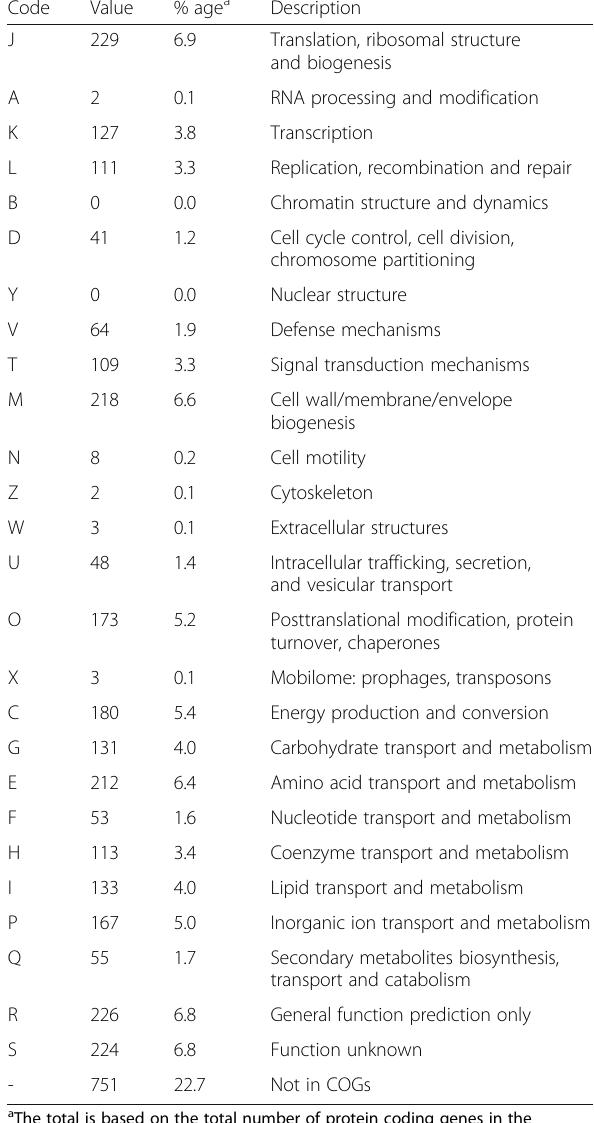
Table 4 Number of genes associated with general